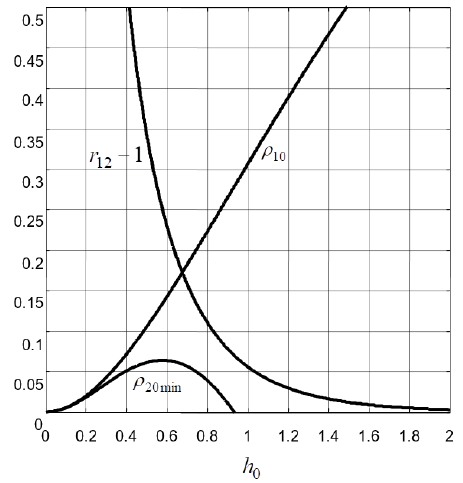
Figure 5. Evolution of ( r 12 , ρ 10 , ρ 20min ) versus h 0